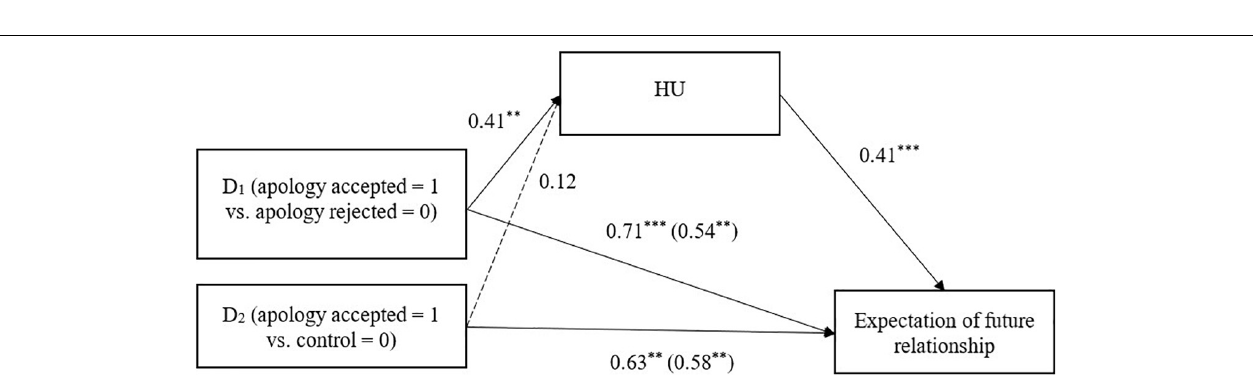
Frontiers in Psychology |